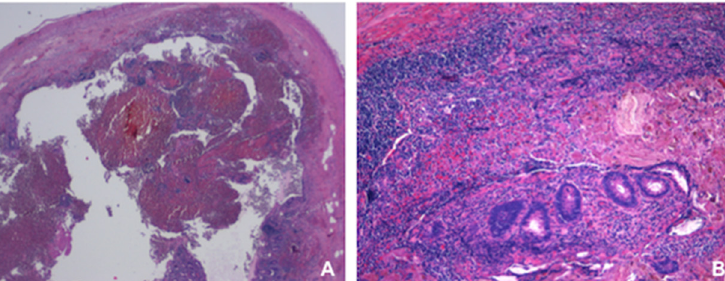
Figure 1. ( A ) Appendix section with grade 4 of inflammation extended also to the serosa and associated with necrosis and hemorrhage (H&E, original magnification × 2.5). ( B ) Appendix section with grade 4 of inflammation and diffuse necrosis (H&E, original magnification ×